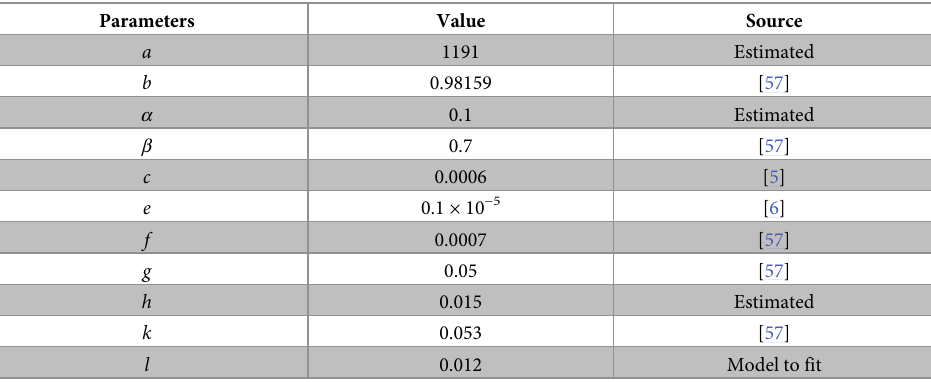
Table 2. Parameter values for numerical